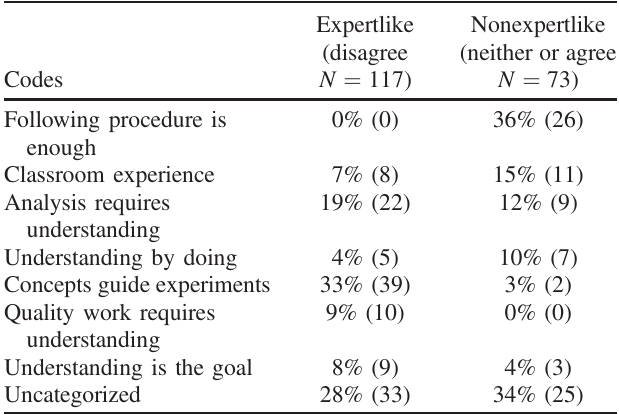
TABLE VIII. Student views about Q3 “ I am usually able to complete an experiment without understanding the equations and physics ideas that describe the system I am investigating. ” The percent of students with expertlike or nonexpertlike Likert-scale selections whose reasoning contained particular codes. Students ’ reasoning may be coded under several codes when appropriate, so percents in each column may not add up to 100%. N is the total number of students with expertlike or nonexpertlike views and the number of students with each code is given in parentheses. Codes with total frequency less than 10 (around 5% of the total population) are not